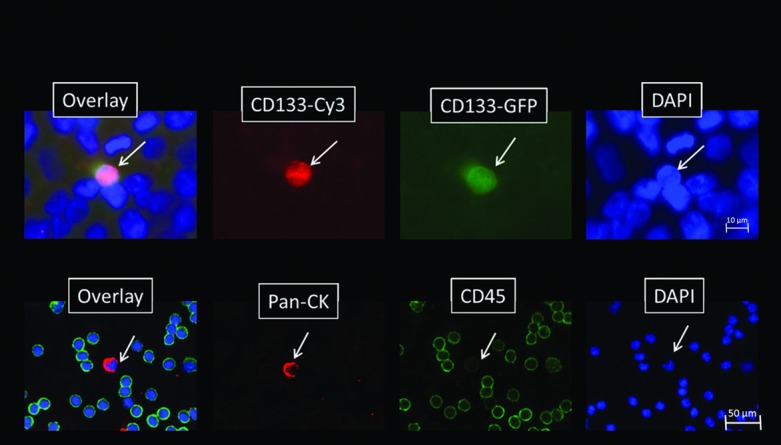
CTC detection.A) Positive control consisting of PBMNC mixed with CD133-expressing K562 cells which were stably transduced with lentiviral vectors endocoding an internal ribosomal entry site (IRES)-mediated co-expression cassette of CD133 and enhanced green fluorescent protein (eGFP) (K562-CD133:IEG). Cells were stained with DAPI (nucleus; blue) and for CD133 (pseudo-color red). The antibodies used for anti-CD133 immunostaining specifically bound to K562-CD133:IEG cells, visualized by Cy3 (red) counterstaining (40x magnification). B) CTC isolated from mRCC patients stained with DAPI (blue), for pan-CK (epithelial; red) and for CD45 (hematopoietic; green; 20x magnification). The cell marked with a white arrow shows a DAPI-positive (blue)/CD45-negative staining and was positive for pan-CK (red) and subsequently considered as CTC.